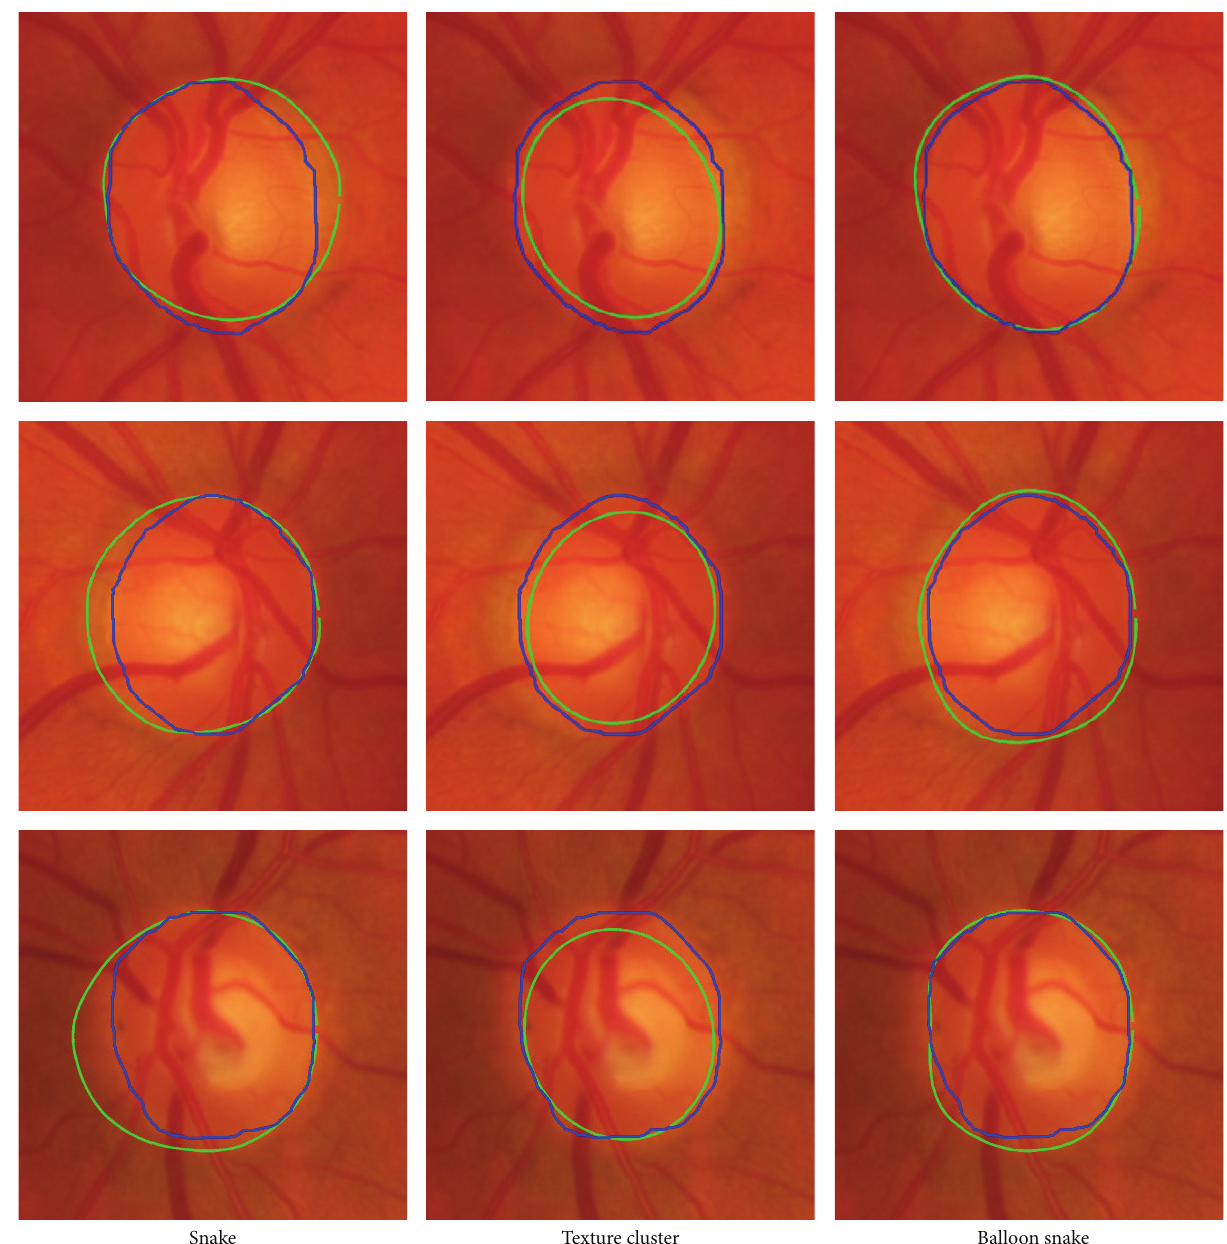
Figure 14: Three segmentation approaches. The blue is the golden mask and green is the segmentation result.